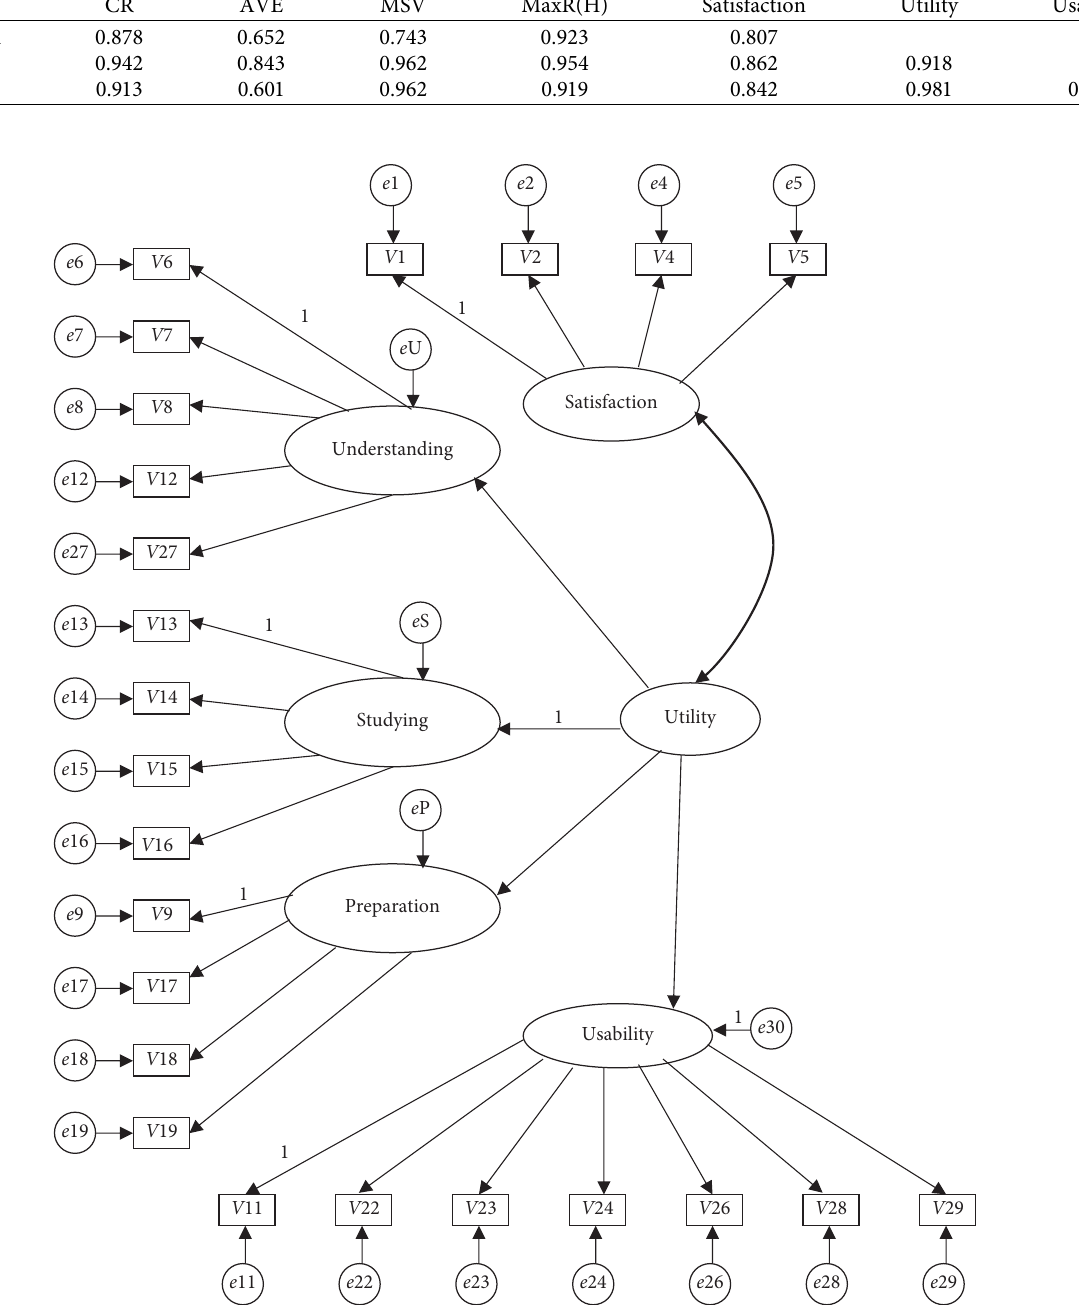
Figure 4: An alternative modified model (model